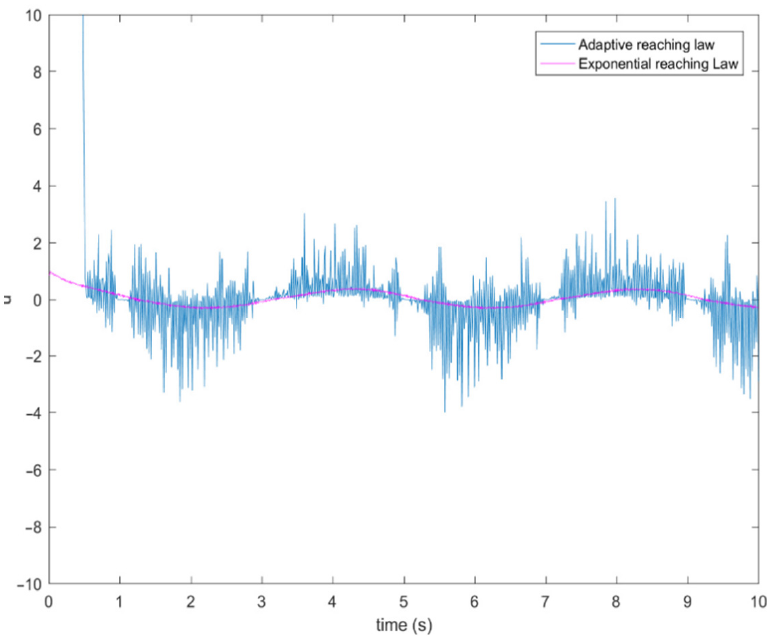
Figure 6. Curves of control variables under different reaching laws.